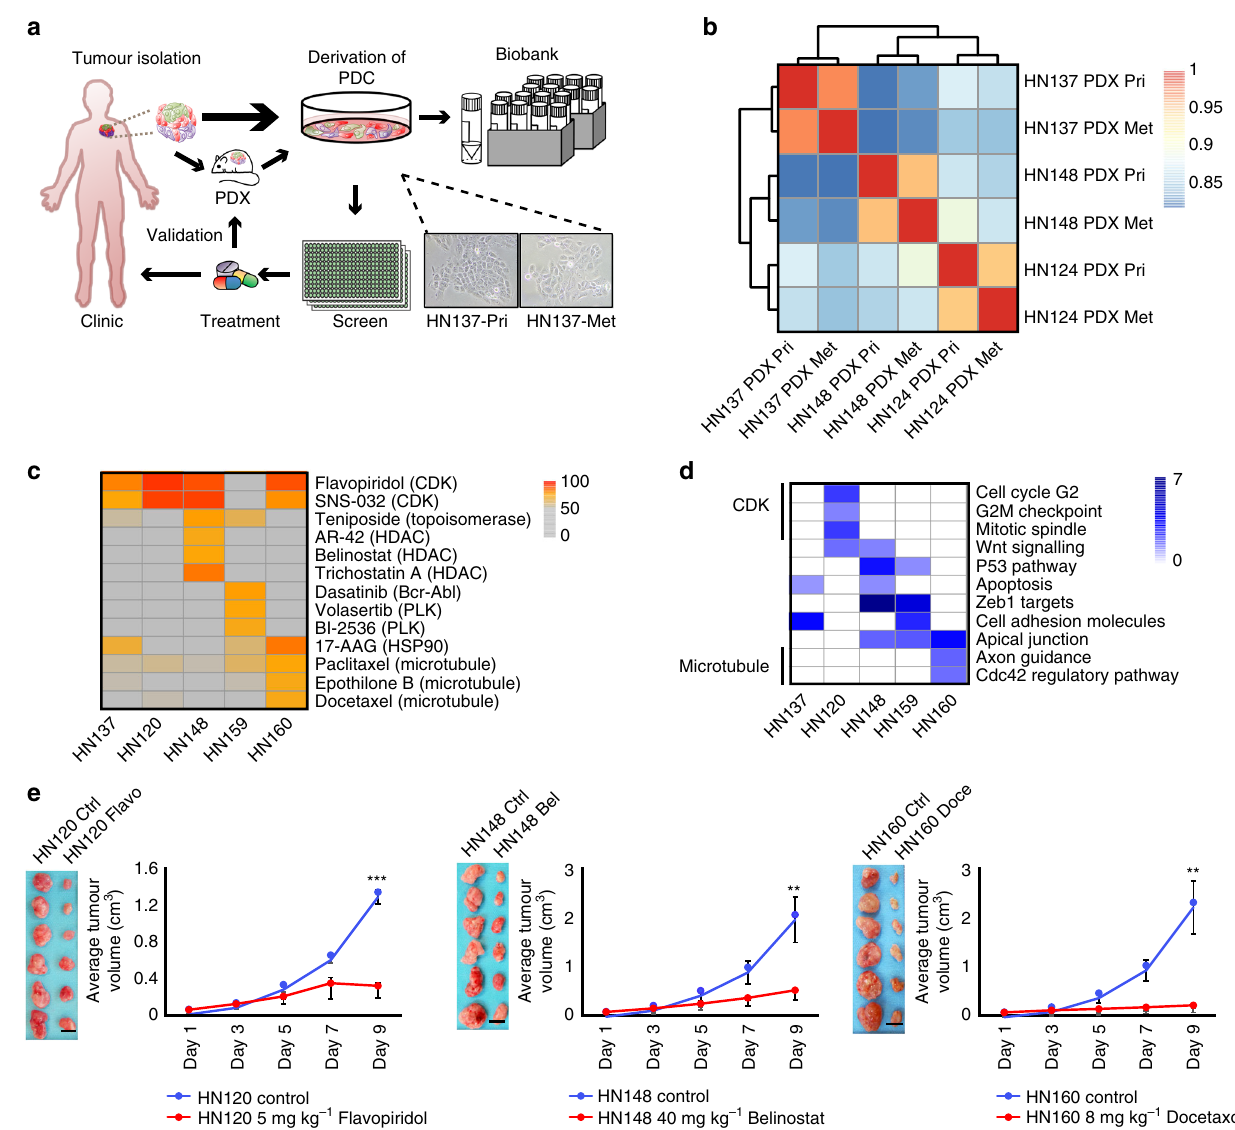
Fig. 1 Establishing a library of screenable in vitro and in vivo patient-speci fi c squamous cell carcinoma (SCC) models for identi fi cation of therapeutic vulnerabilities. a Schematic representation of the pipeline for the generation of patient-personalized in vitro and in vivo models that can serve as a screening platform for uncovering therapeutic vulnerabilities. Resected tumours from human patients were grafted into NSG mice for the establishment of in vivo patient-derived xenograft (PDX) models, and for expansion of tumour material. Patient-derived primary culture (PDC) models were also derived and screened against small molecule libraries for identi fi cation of patient-speci fi c therapeutics. Sections of patient tumours, as well as freeze-viable PDX and PDC models were stored in our biobank. Representative images of HN137-Pri and HN137-Met cultures are shown. b Hierarchical clustering of gene expression pro fi les for HN124, HN137 and HN148 paired primary (Pri) and metastatic (Met) PDXs in duplicates. Scale bar denotes Pearson ’ s correlation coef fi cient r from 0.8 ( blue ) to 1 ( red ). c Heat map of selected anti-cancer compounds exhibiting strong inhibition in at least one of the PDC lines. The scale represents percentage inhibition of the compounds, with inhibition score < 50% shown in grey . d Selected molecular signatures ( P < 0.05) of genes that show elevated expressions across the fi ve Met cell lines, some of which appear to be associated with the selective responses of PDC lines to compounds of same target classes. e Six independent cohorts of mice ( n = 6) bearing patient-matched PDX in one fl ank were treated with vehicle (control), 5 mg kg − 1 Flavopiridol (HN120), 40 mg kg − 1 Belinostat (HN148) and 8 mg kg − 1 Docetaxol (HN160). Scale bar , 1 cm. Error bars represent mean ± s.e.m. Two-tail Student ’ s t test was carried out between treatment and control groups on day 9 tumour weight. ** P value < 0.01 and *** P value <